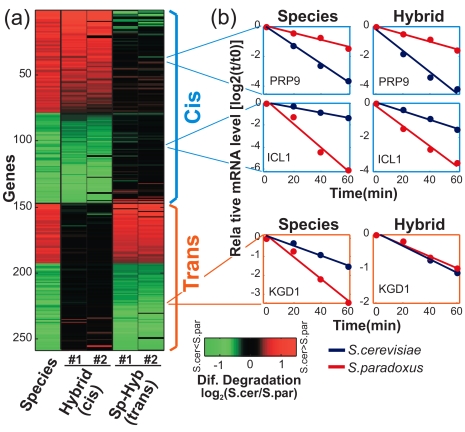
Cis and trans divergence of mRNA degradation.Classification of inter-species differences in mRNA degradation rates into cis and trans based on the extent of differences observed between the two hybrid alleles (see Materials and Methods). (a) Heatmap of the differences in mRNA degradation rates, log2(S. cer/S. par), between the two species (left column), between the corresponding hybrid alleles (middle columns, reflecting only the cis component), and the subtraction of the species and hybrid differences (right columns, reflecting only the trans component). (b) mRNA degradation profiles of the two species (left) and the corresponding hybrid alleles (right) are shown for two examples of cis-differences (top) and one example of trans-difference (bottom).